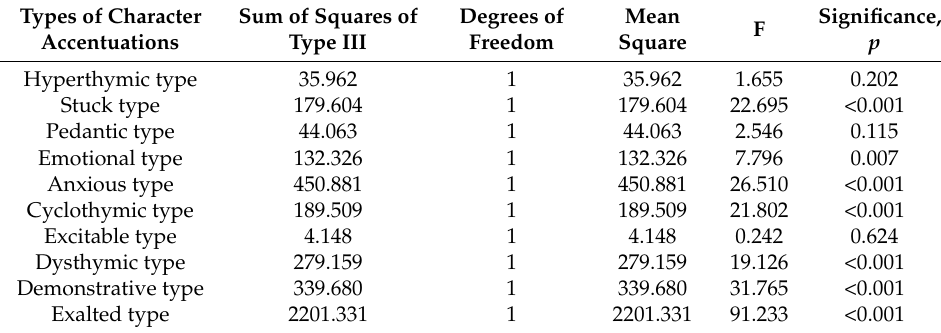
Table 3. Results of one-dimensional tests.